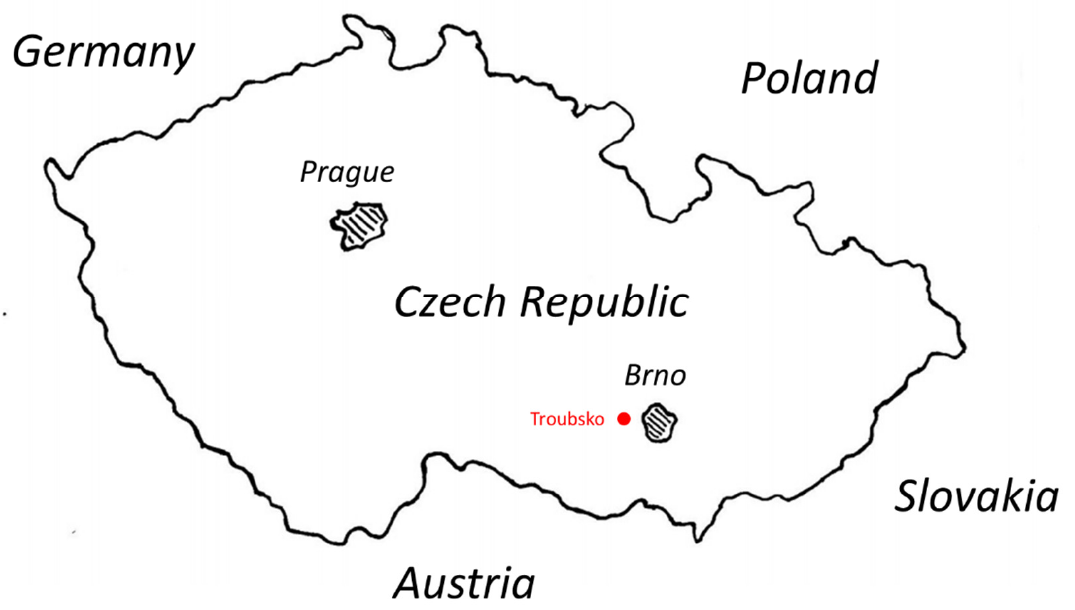
Figure A1. Localization of the Troubsko experimental field station in CZE (Czech Republic) and European Union.